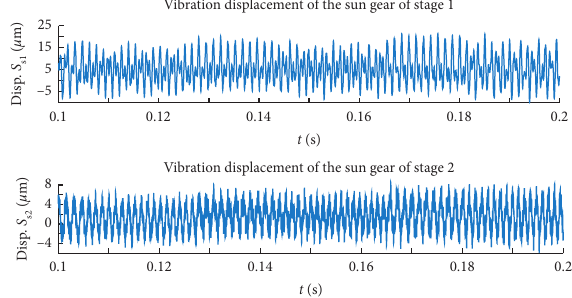
Figure 6: Vibration displacement of the sun gear.